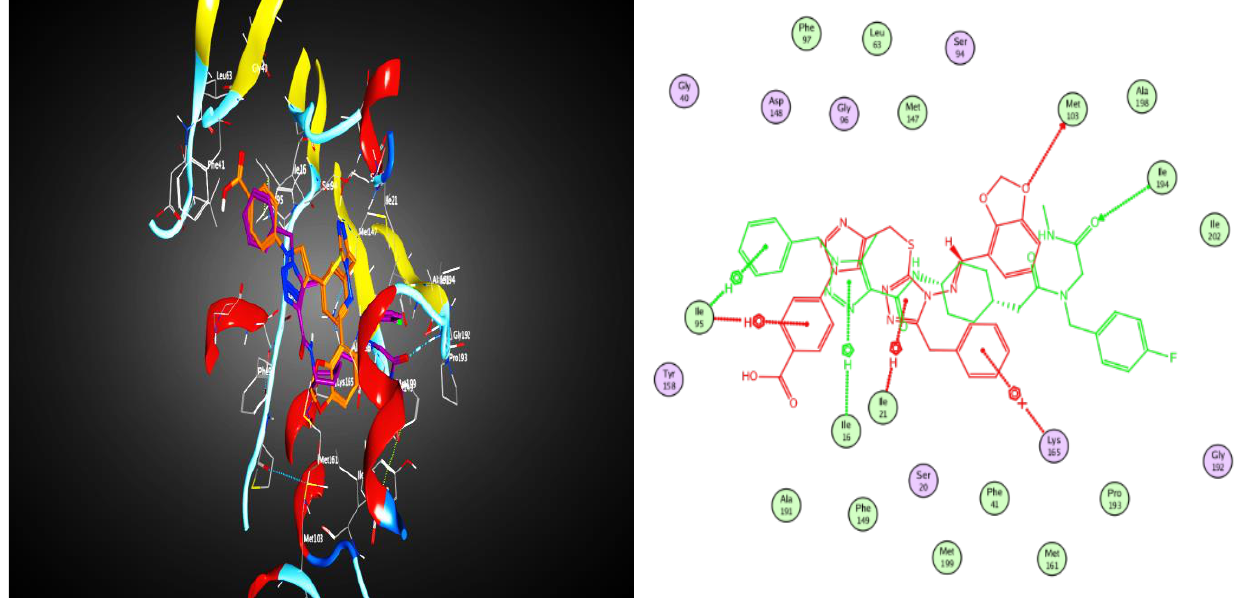
Figure 11. An overlay of the docked pose of compound 7c (brown) with Lead structure B (purple) into inhA active site in 2D (right panel) and 3D (left panel).